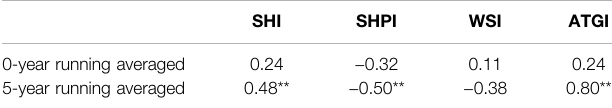
TABLE 1 | Correlation coef fi cients between AMO and each meteorological